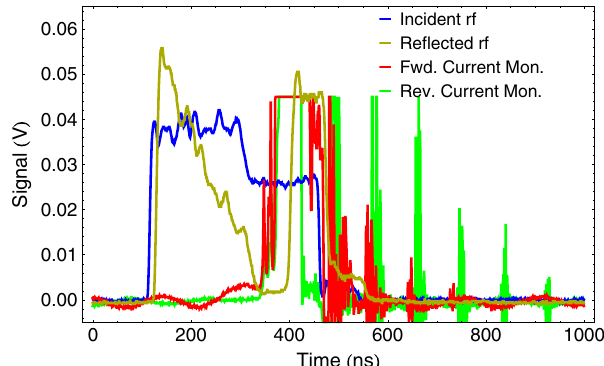
FIG. 12. A sample set of scope traces showing a breakdown shot, as indicated by the peaks in the current monitor signals, and an increase in reflected rf signal. This is a 150 ns shot at approximately 125 MV = m gradient. The measured incident power is shown in blue, and the measured reflected power is shown in yellow. The forward and reverse current monitor signals are shown in red and green, respectively. Note that the currents generated by the breakdowns saturate the current monitors.